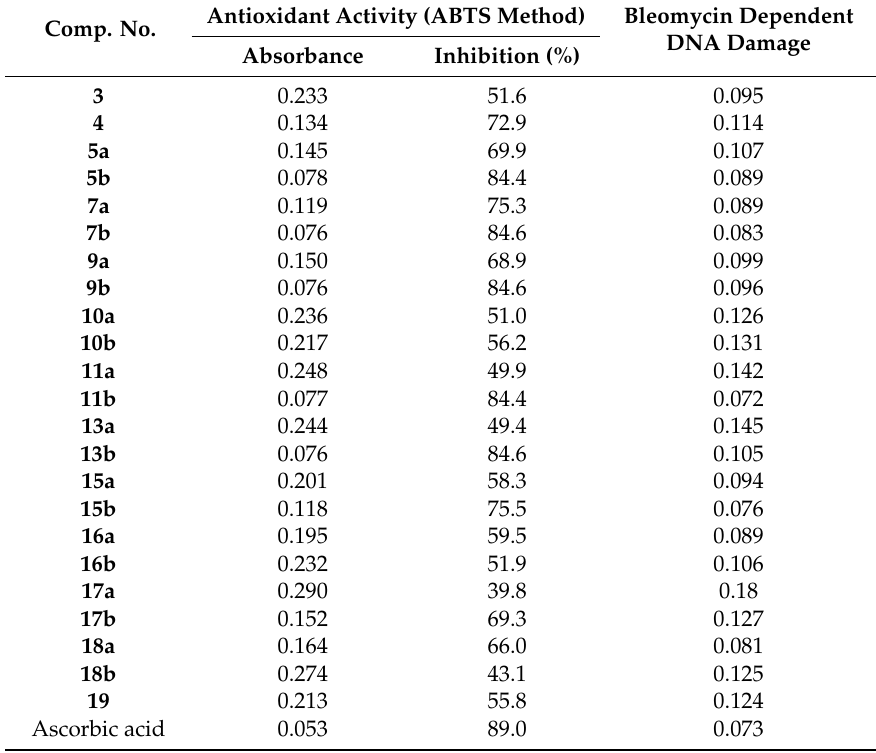
Table 2. Antioxidant activity and bleomycin-dependent DNA damage for the tested compounds a . Comp.